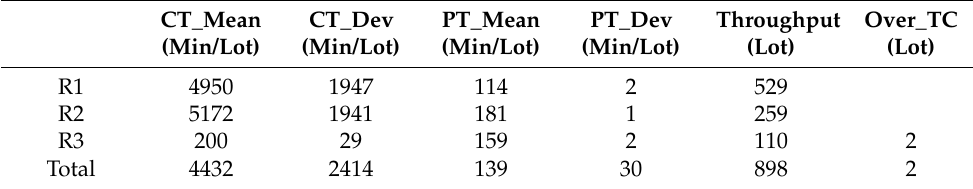
Table 5. Performance of FIFO model with taking TC into account.